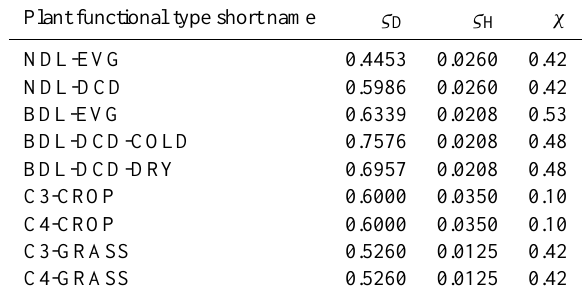
Table A3. PFT-specific base respiration rates (kgC ( kgC ) − 1 yr − 1 ) for the litter ( ς D ) and soil carbon ( ς H ) pools (Eq. A31) and the hu- mification factor ( χ , Eq. A37) used in the heterotrophic respiration module of CTEM v.